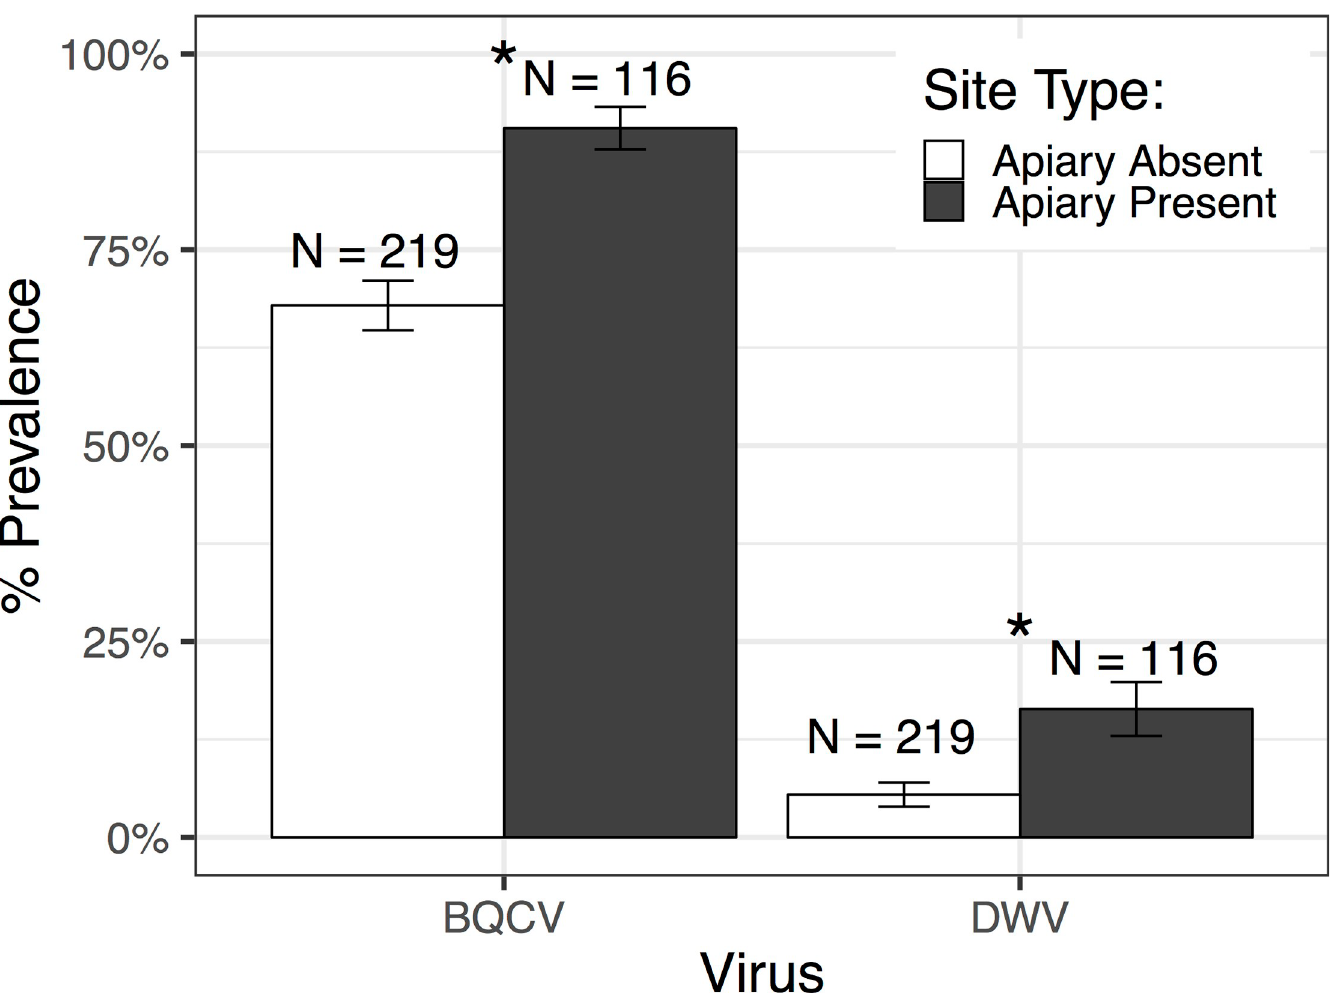
Fig 1. Percent prevalence of infected bumblebee individuals for black queen cell virus (BQCV) and deformed wing virus (DWV). Bumblebees were either caught in sites with honeybee apiaries present or no apiary nearby. BQCV and DWV were more prevalent in bumblebees caught in sites with a honeybee apiary present than in sites without an apiary nearby. Standard error bars are shown. Asterisks represent